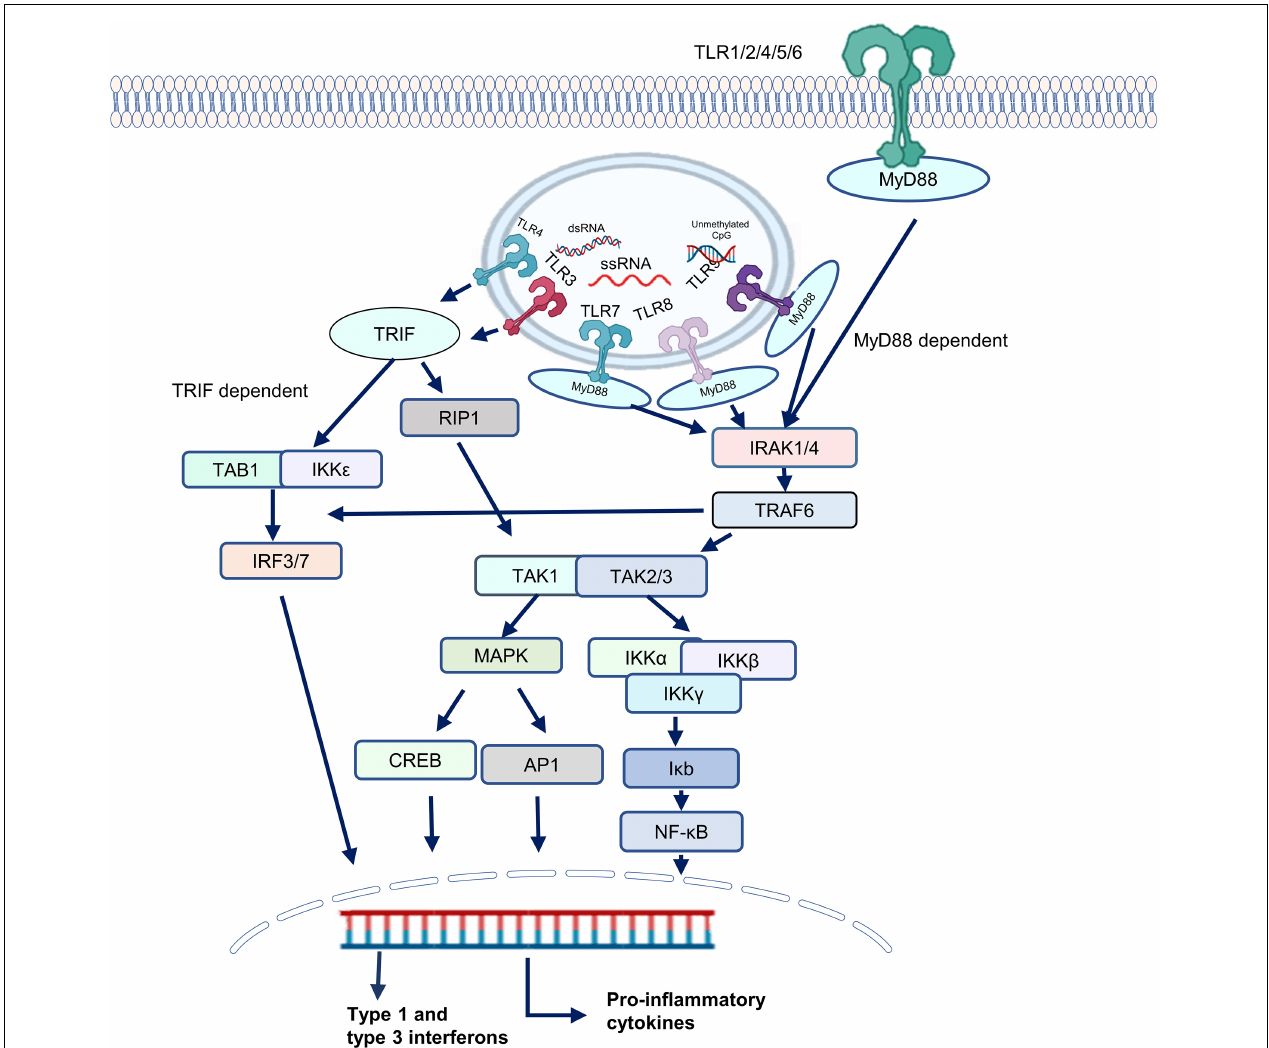
FIGURE 1 | The Toll-like receptor (TLR) signaling pathway. TLRs are categorized into two groups depending upon whether they utilize a MyD88-dependent pathway or a TRIF-dependent pathway. TLRs 1,2, and 5–9 transmit signals through a MyD88-dependent pathway, whereas TLR3 signaling is mediated by a MyD88-independent pathway. By contrast, TLR4 can signal through MyD88-dependent and MyD88-independent pathways. In case of MyD88-dependent signaling, IL-1R-associated kinases 1/4 (IRAK1/4) recruit TNF receptor–associated factor 6 (TRAF6). TRAF6 can also stimulate interferon signaling by recruitment of IRFs. TRAF6 activates TAK1 which activates two distinct pathways, one of which leads to the activation of the IKK complex-NF- κ B pathway and the other to the activation of the mitogen activated protein kinases (MAPKs). The catalytic subunits IKK α , IKK β , and IKK γ make up the IKK complex. IKK β is also activated by TAK1. The IKK complex phosphorylates the NF- κ B inhibitory protein I κ B α , which is then degraded by the proteasome, allowing NF- κ B to enter the nucleus. TAK1 activation triggers the activation of MAPK family members leads to the activation of transcription factors such cyclic AMP-responsive element-binding protein (CREB), and activator protein 1 (AP-1). CREB, AP-1 and NF- κ B then stimulate proinflammatory mediators and interferons. However, in case of TRIF-dependent signaling, IRF3 and IRF7 are recruited which lead to secretion of type 1 and type 3 interferon.